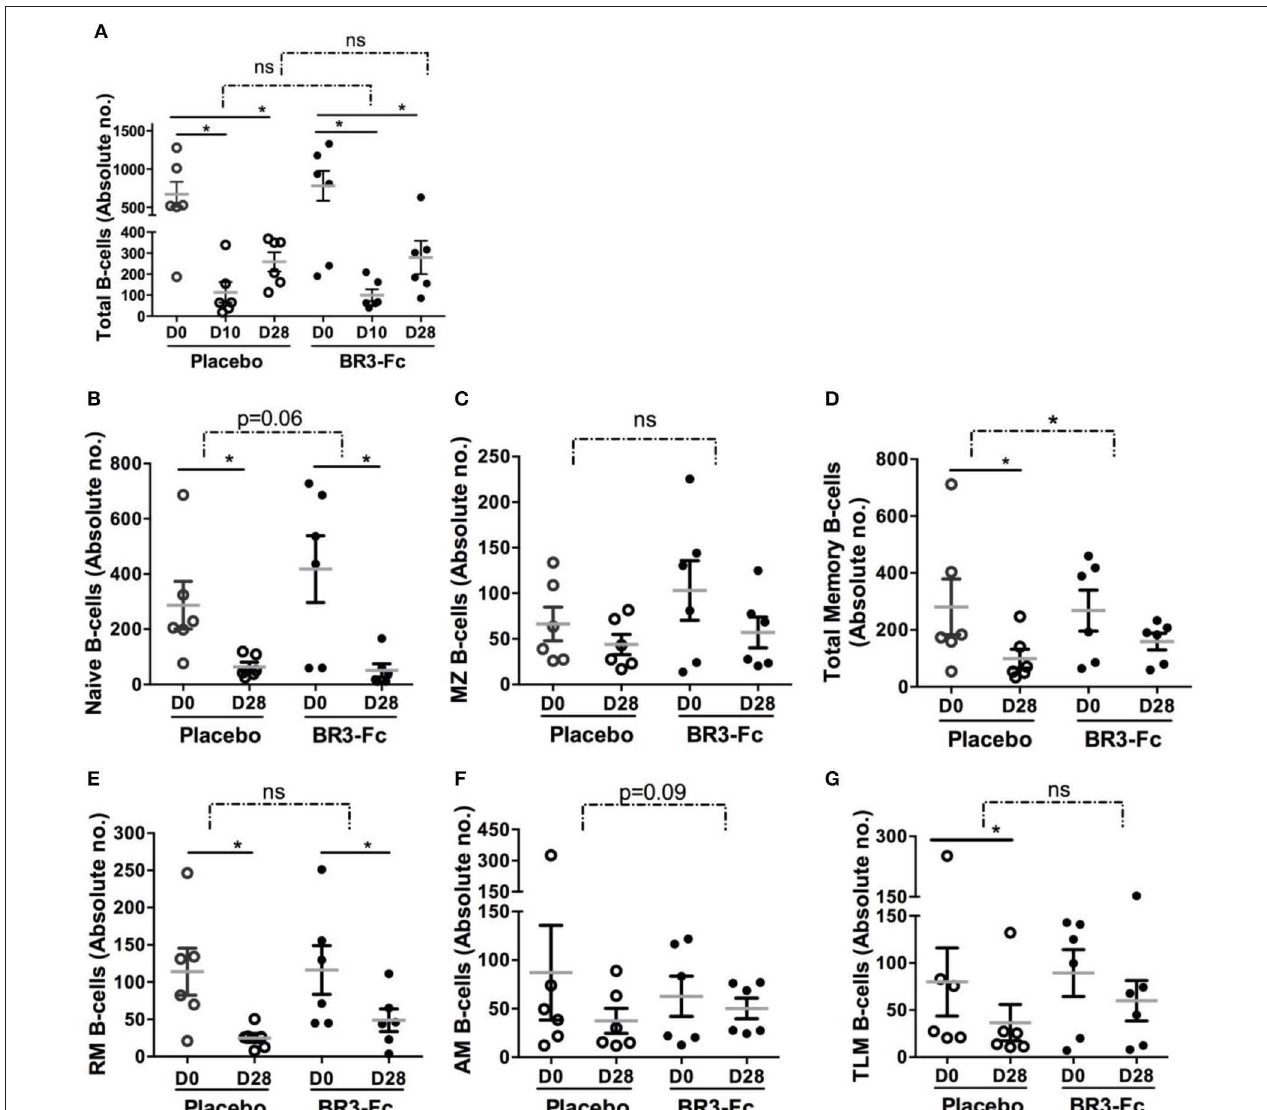
FIGURE 3 | BR3-Fc treatment reduces SIV-induced loss in blood memory B-cells. Blood B-cell phenotype was determined by Flow cytometry and absolute numbers of every B-cell subset were calculated according to the whole blood cell count. Samples from 6 Placebos and 6 Treated macaques were compared. (A) Absolute numbers of total B-cells were plotted for each macaque before infection (D0) at 10 dpi (D10) and 28 dpi (D28). For (B–G) , only absolute numbers at D0 and D28 were plotted. Each dot on the graphs represents one macaque of Placebo ( open circle ) or Treated ( black circle ) group. Bars represent Mean values ± SEM. Statistics were first carried out to compare values at 10 (D10) and 28 (D28) dpi with those prior to infection (D0) for each macaque using the Wilcoxon matched-pairs signed rank test. Significant statistical values are indicted ( plain line, * p < 0.05). B-cell loss corresponding to difference between absolute numbers at D10 and D0 (A) and D28 and D0 (all panels) was also compared between groups using the Mann Whitney non-parametric test. Statistical values are indicated for each panel ( dotted line and p-value, * p < 0.05). ns : not